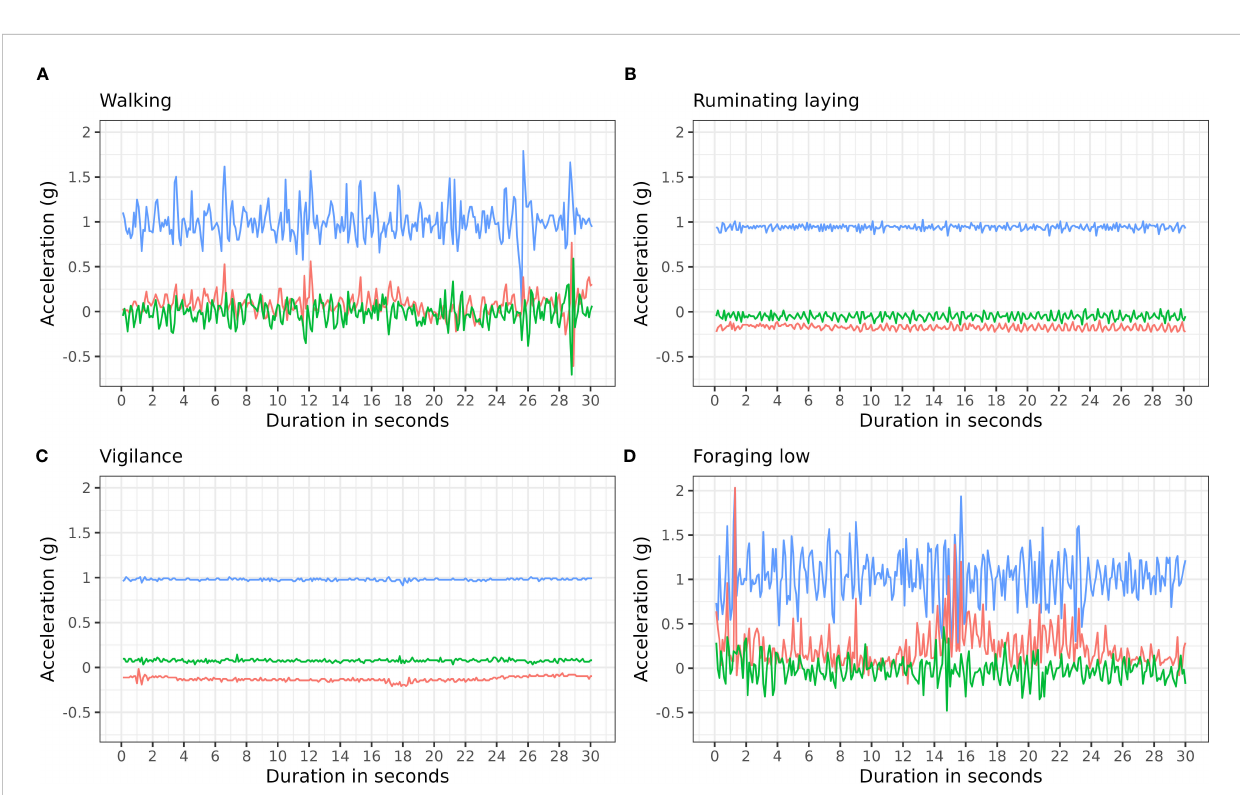
FIGURE 3 Example of four behaviors and their raw accelerometry signature for the duration of 30 seconds (300 observations). For the behaviors; (A) Walking, (B) Ruminating laying, (C) Vigilance, and (D) Foraging low. Line color indicate the different axis; blue: z axis, red: x axis, green: y axis. The proportion of observations for each of these behaviors is 9%, 23%, 8%, 33%, respectively. See the full overview of behaviors in Supplementary Table